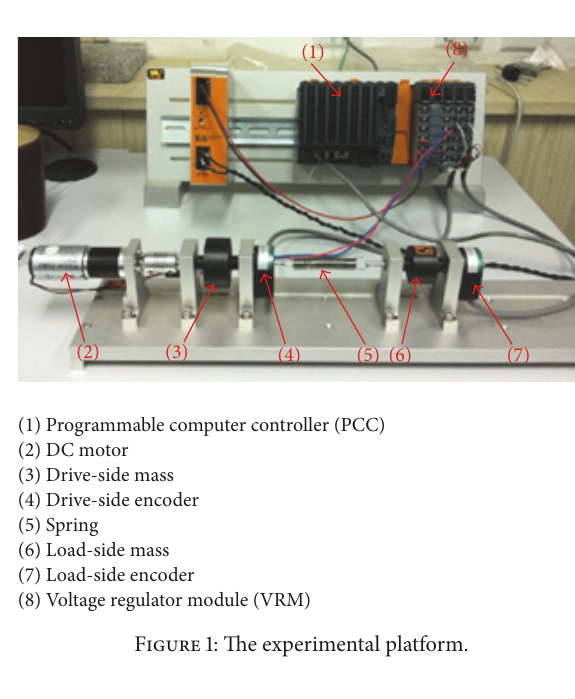
Figure 1: The experimental